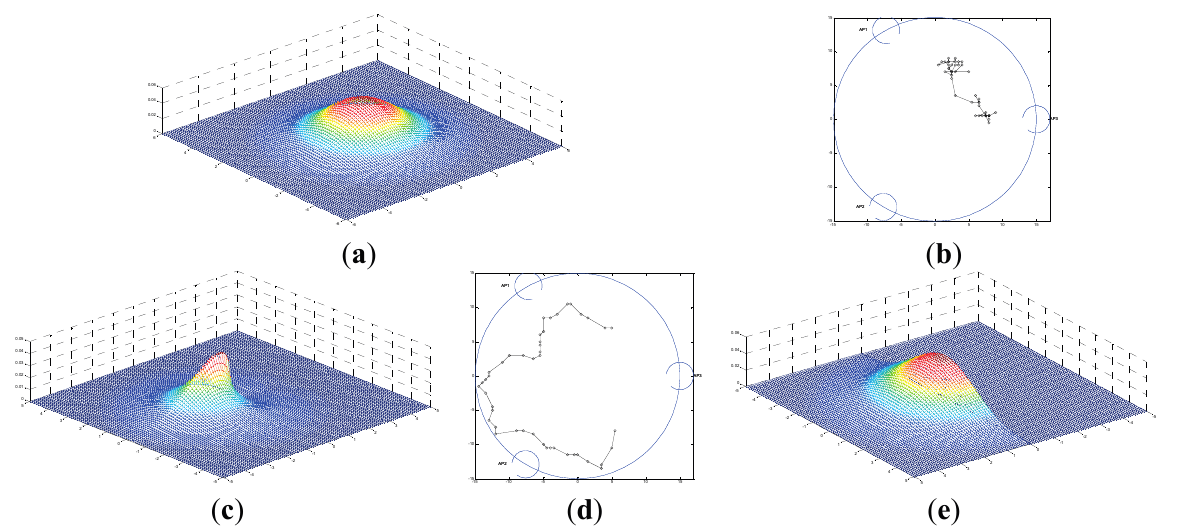
( d ) ( e ) Figure 4. Examples of -1 ( | ) i i p m m PDF models. The arrows represent the forward direction σ = in [16]; ( b ) Trajectory of ( a of the MT: ( a ) Circular Gaussian PDF with deviation 3 v